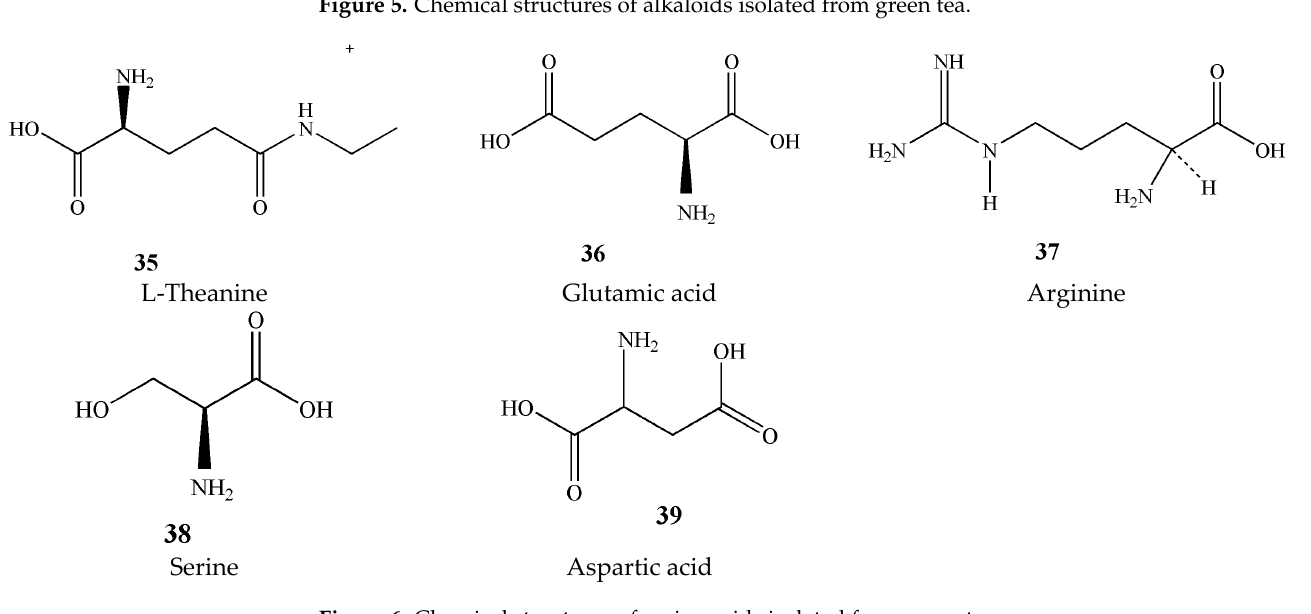
Figure 6. Chemical structures of amino acids isolated from green